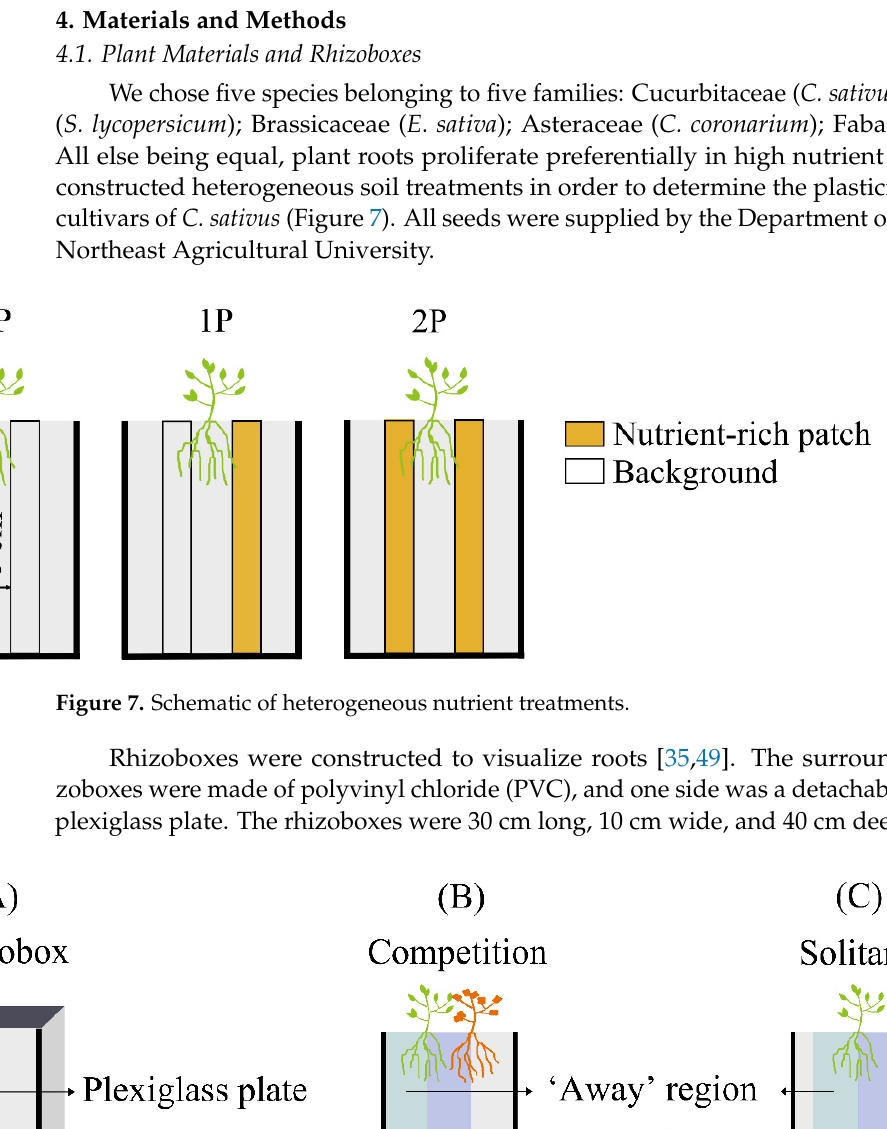
Figure 8. Illustration of the experimental rhizobox and design. ( A ) The structure and size of the rhizobox; ( B ) neighbor treatment (competition); ( C ) no neighbor treatment (solitary). Roots grow away from the neighbor in the ‘away’ region and those towards the neighbor in the ‘towards’ region.